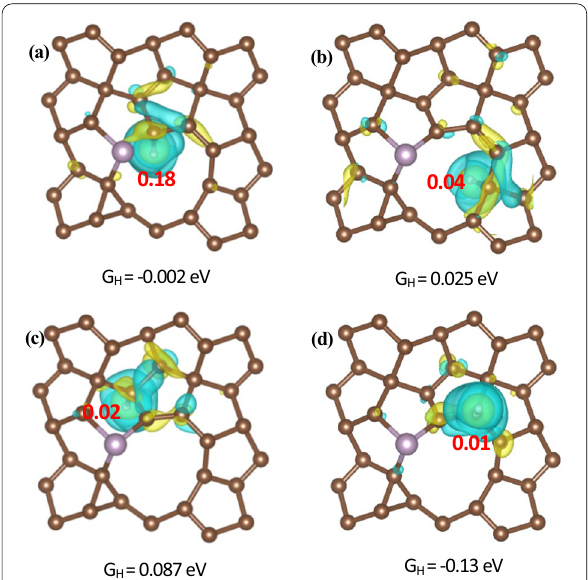
Fig. 6 Top views of electron charge density difference and Bader charges analysis for a C 2-DOWN vacancy and P-doped PG with H adsorbed at the a C1, b C 2-DOWN , c C 2-DOWN n and d C 2-UP sites. The isosurface level is 0.004 e/Bohr 3 . The yellow and blue colors represent charge accumulation and reduction,